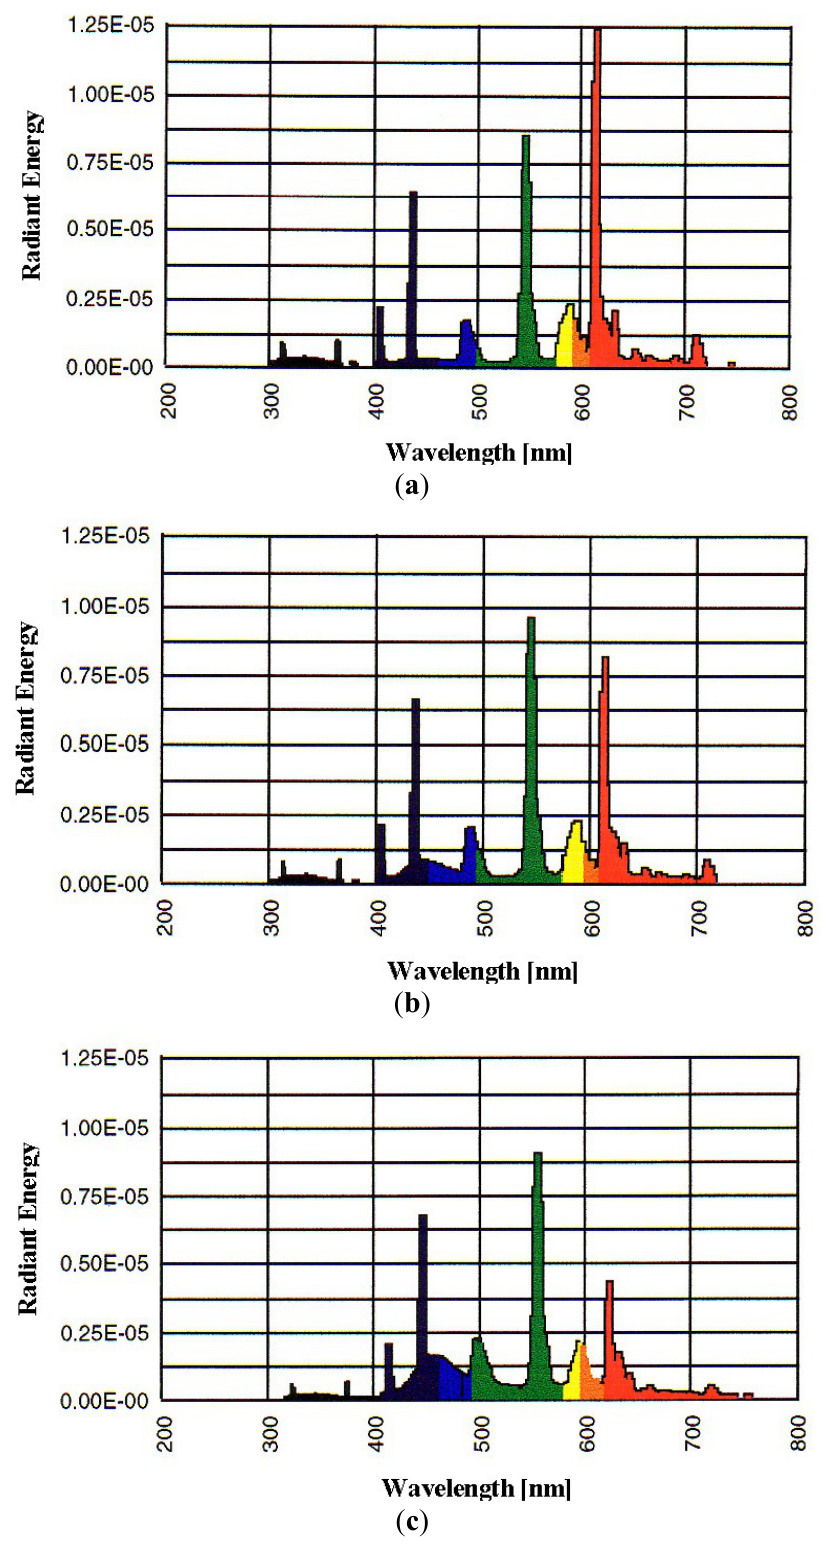
Figure 3. Spectral Distribution of Fluorescent Lamp [5]. ( a ): 3,000 K; ( b ): 4,000 K; ( c ): 6,500 K. Reprinted with permission from